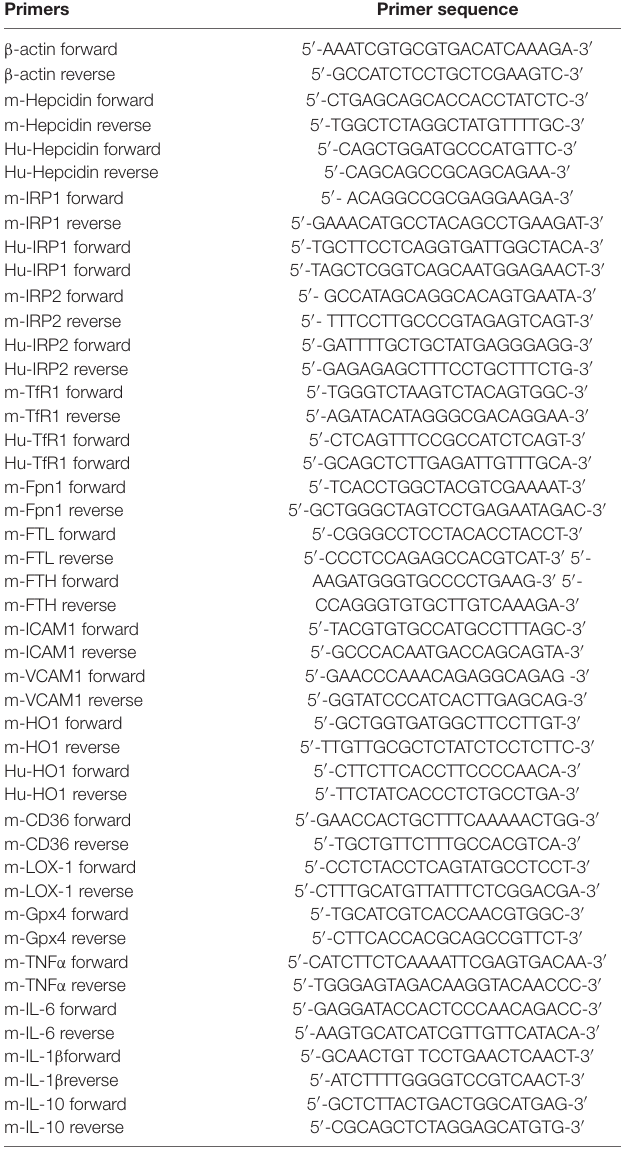
TABLE 1 | The specific pairs of primers. Primers Primer